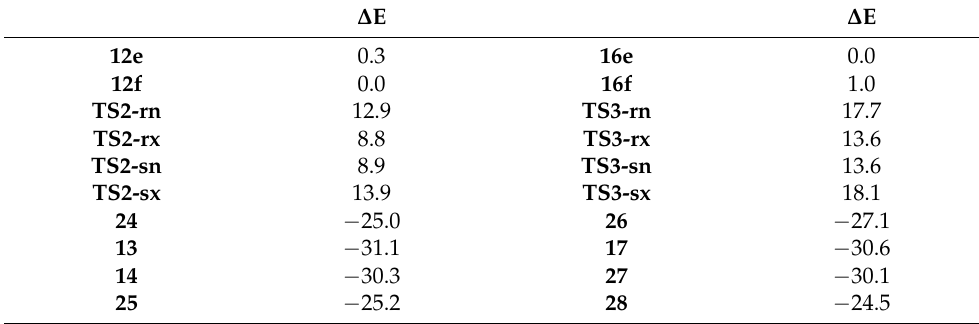
Table 4. ω B97XD/6-311G(d,p) relative energies ( ∆ E, in kcal · mol − 1 , with respect to the most stable conformation) in ethanol of the stationary points involved in the IIDA reactions of dieniminiums 12 and 16 .